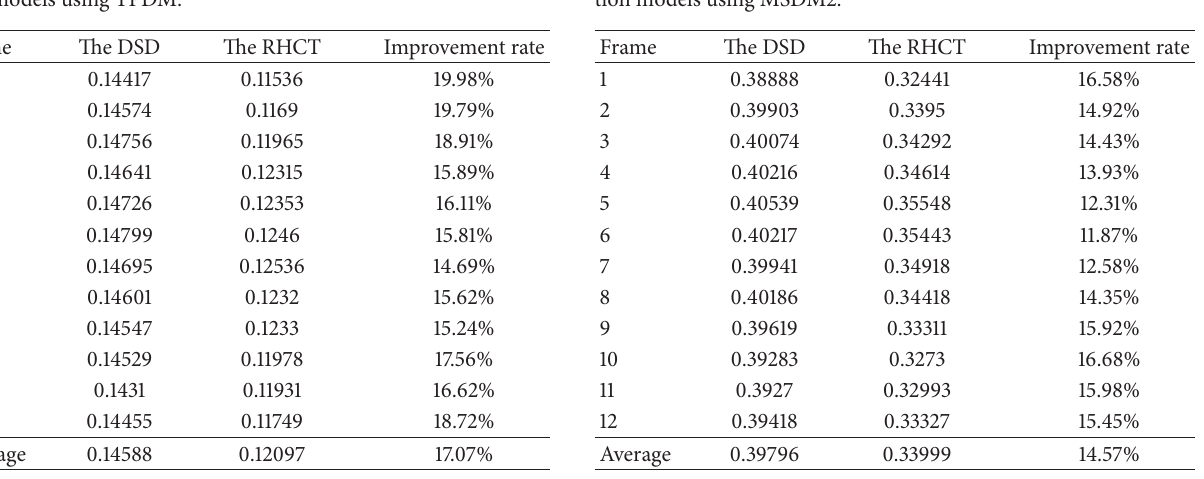
Table 4: Perceived quality comparison for simplified horse anima- tion models using TPDM.